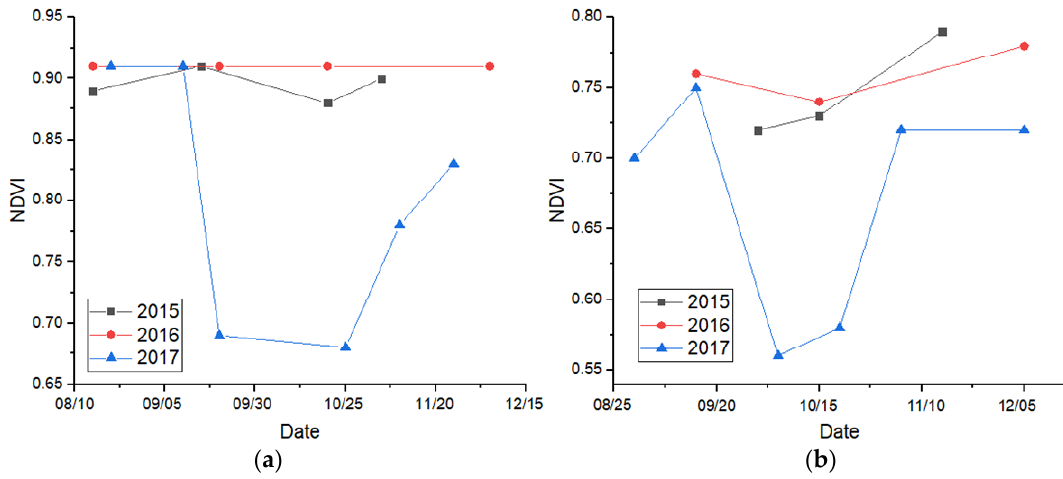
Figure 7. The NDVI changes in long ‐ term. ( a ) Dominica; ( b ) Puerto Rico.